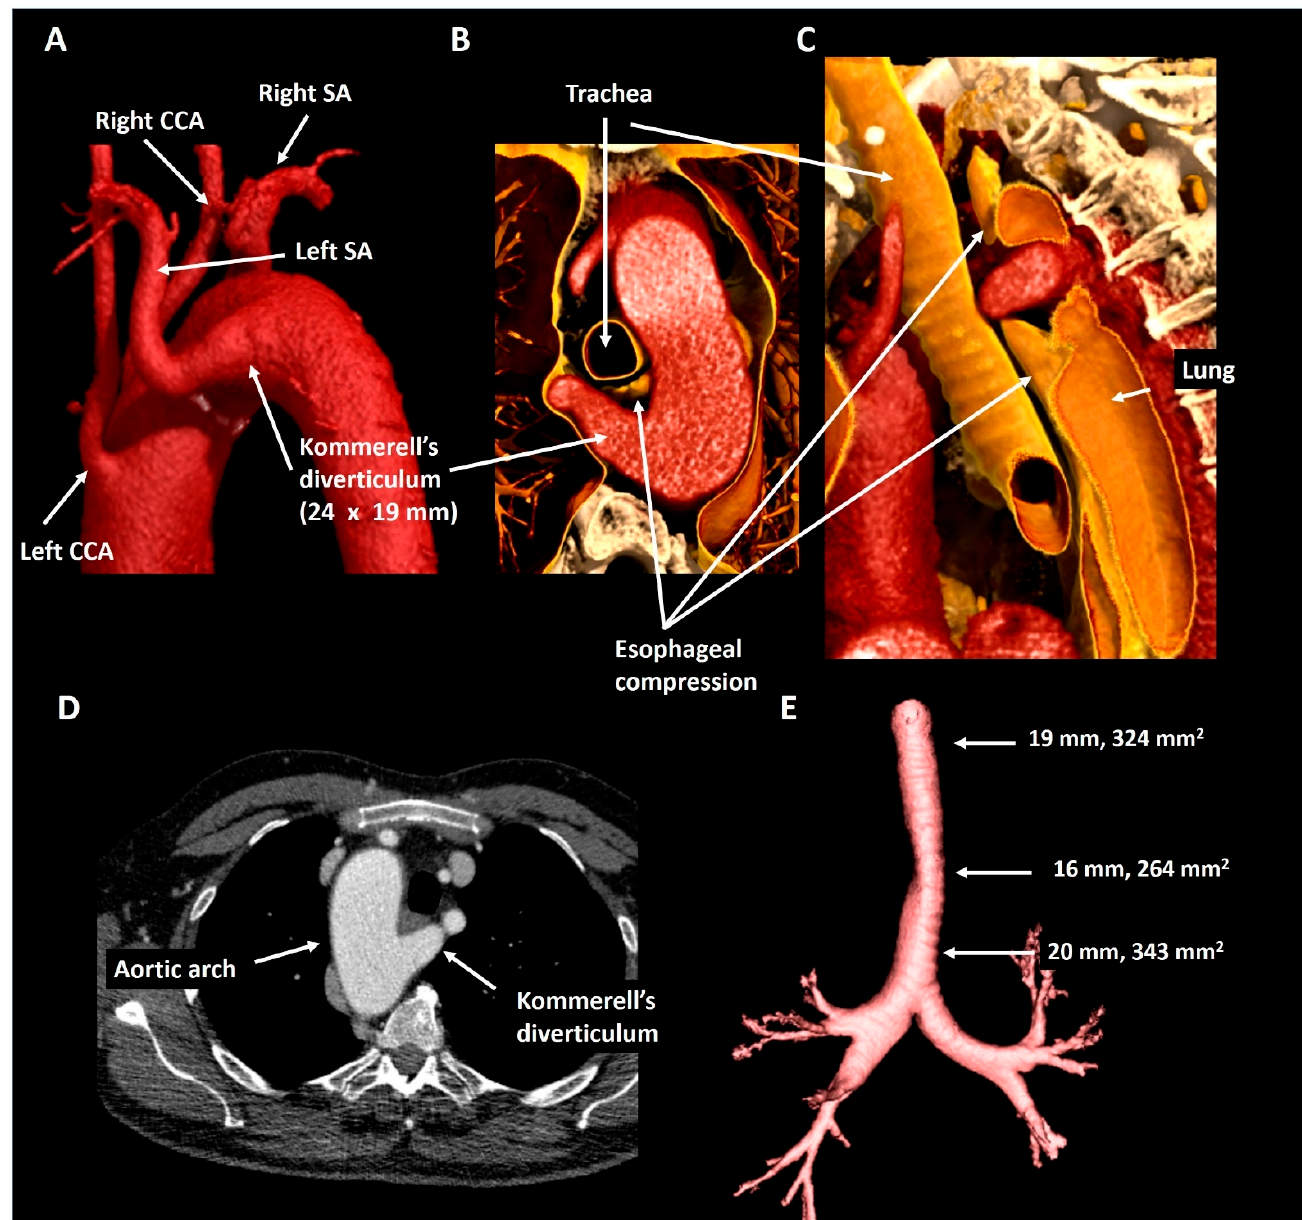
Figure 7. Patient 5. Panel ( A ) shows a posterolateral view depicting a right-sided aortic arch and an aberrant left subclavian artery with a Kommerell’s diverticulum. The axial (panel ( B )) and oblique sagittal (panel ( C )) lateral 3D volume rendering reconstructions reveal that the Kommerell’s diverticulum causes esophageal compression. Panel ( D ) shows the axial reconstruction and in panel ( E ) the mild tracheal compression is viewed in isolation. CCA, common carotid artery; SA, subclavian